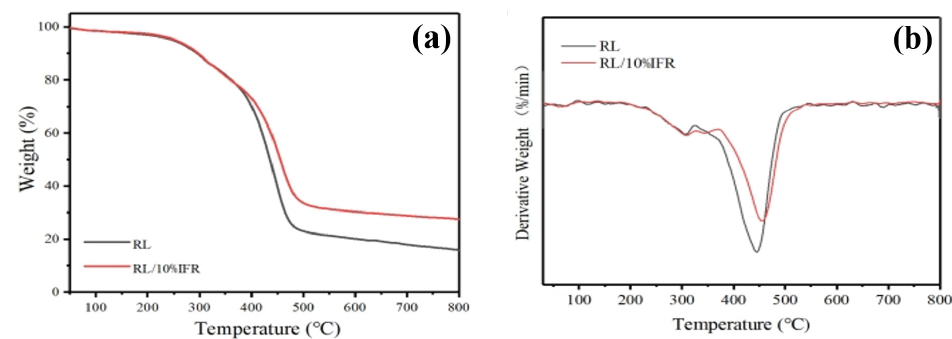
Figure 3. ( a ) TG and ( b ) DTG curves of flame retardant RL and RL/IFR Figure 3. ( a )TG and ( b ) DTG curves of flame retardant RL and RL/IFR membranes.